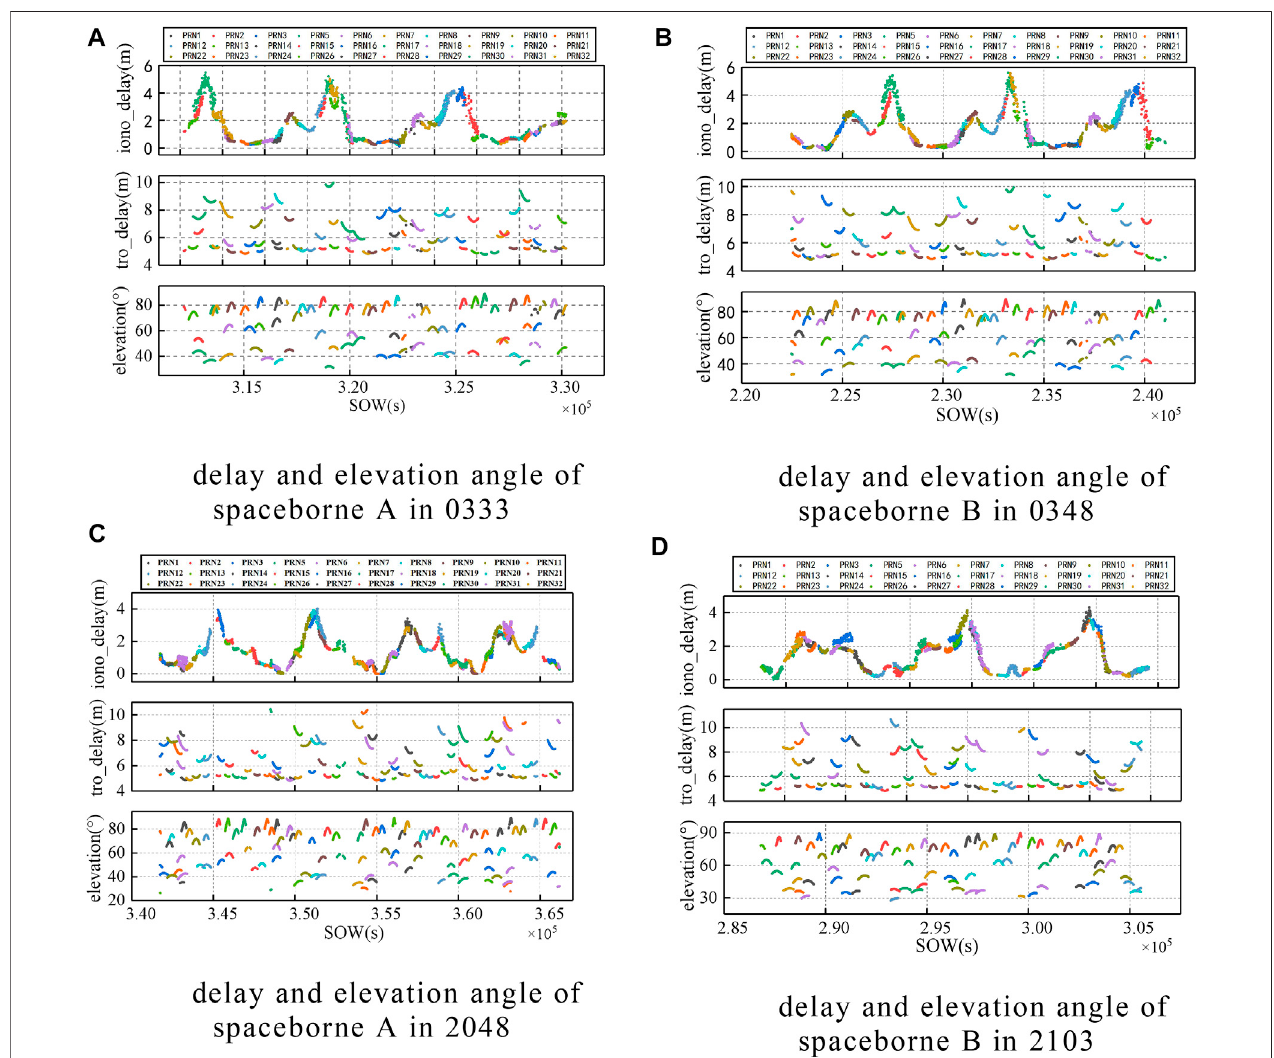
FIGURE 7 | Results of spaceborne experimental atmospheric delay: (numbers represent time, the subgraphs are ionospheric delay, tropospheric delay, and specular point elevation angle from top to bottom). Delay and elevation angle of (A) spaceborne A in 0333, (B) spaceborne B in 0348, (C) spaceborne A in 2048, (D) spaceborne B in